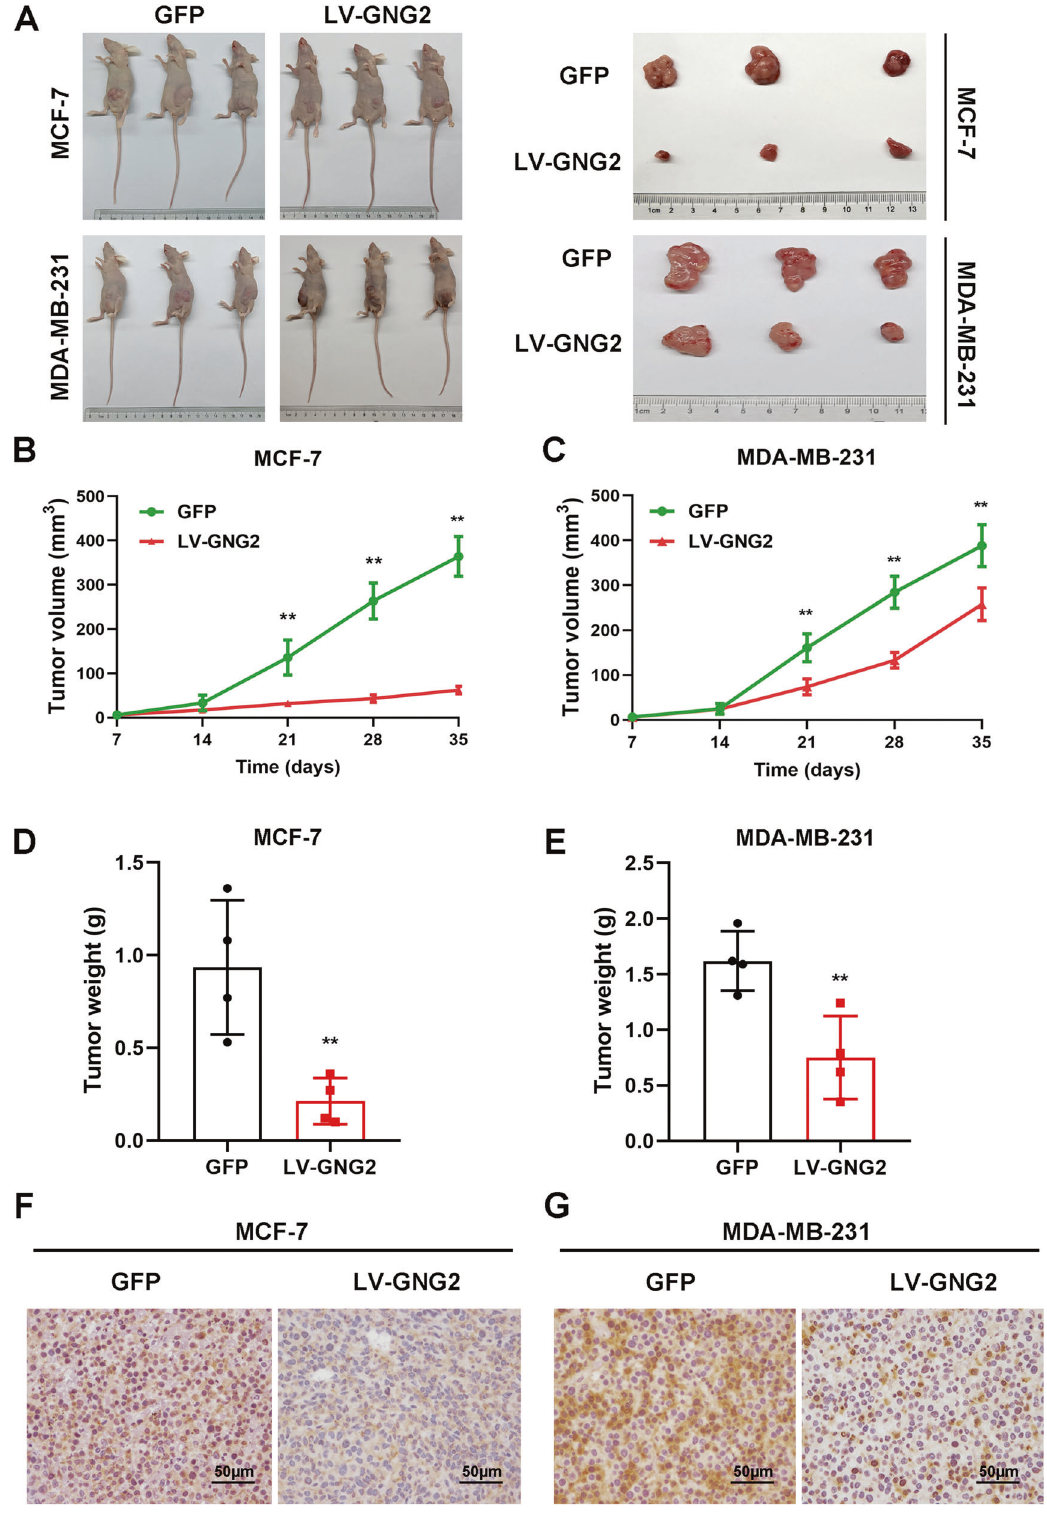
Fig. 5 GNG2 inhibits BC tumorigenesis in vivo. Female nude mice were subcutaneously injected with LV- GNG2 - or LV- GFP -infected MCF-7 or MDAMB-231 cells as described in Methods. A Photos of the tumor-bearing nude mice and the xenograft tumors dissected from the nude mice. B and C Tumor growth curves in nude mice injected with MCF-7 ( B ) and MDAMB-231 ( C ) cells. D and E The weight of xenograft tumors from mice injected with MCF-7 ( D ) and MDA-MB-231 ( E ) cells ( n = 4). F and G Immunohistochemical analysis of Ki67 protein in tumor tissues transfected with GNG2-overexpressing MCF-7 ( F ) and MDA-MB-231 ( G ) cells (magni fi cation of 400×), Scale bars, 50 μ m. Data are expressed as the mean ± SD. * p < 0.05, ** p < 0.01 vs. GFP.